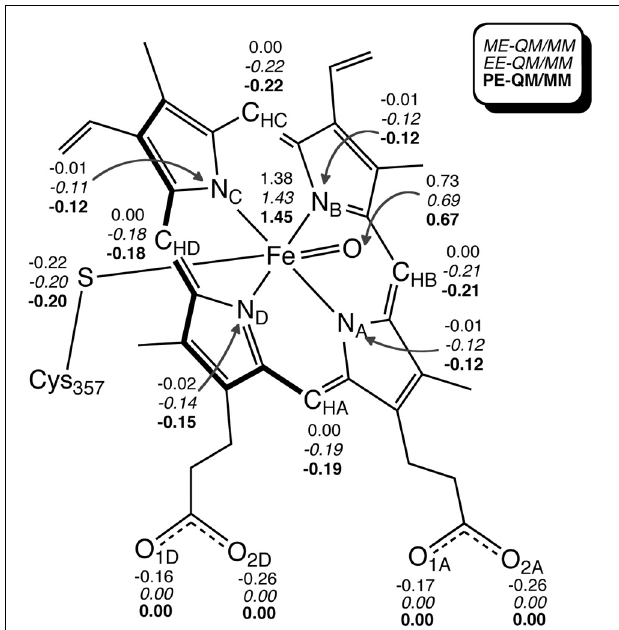
FIGURE 12 | Key Mulliken atomic spin populations obtained with ME-QM/MM (gas-phase), EE-QM/MM, and PE-QM/MM. Reprinted from Thellamurege and Hirao (2014) with permission from the American Chemical Society.